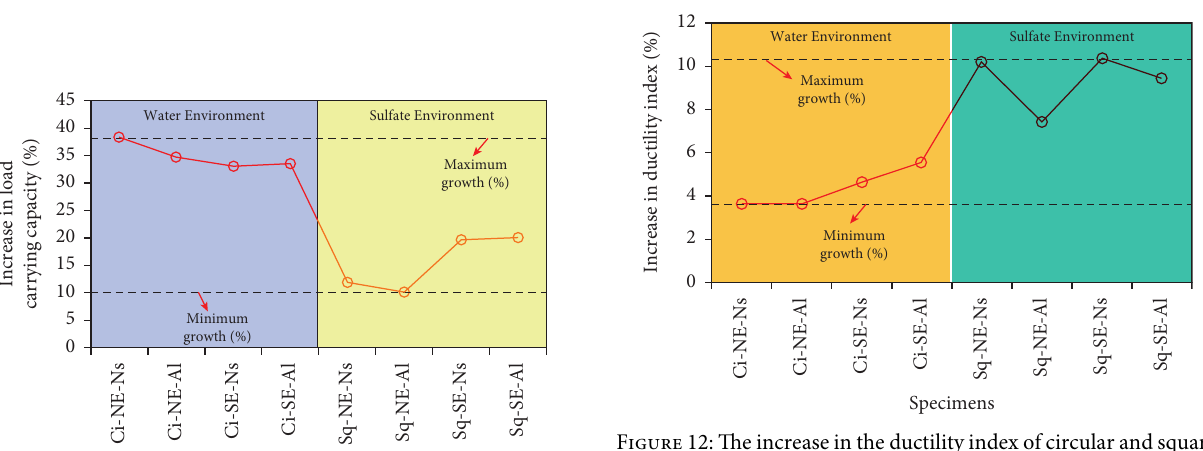
Figure 9: Comparison of the bearing capacity of columns in diferent states.